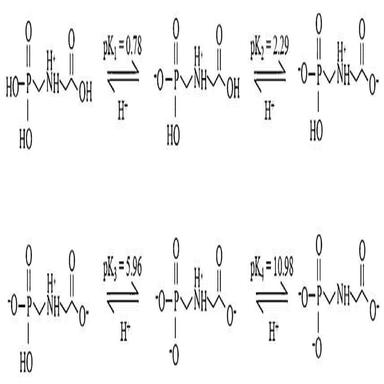
Acid–base forms of glyphosate and related ionization constants.